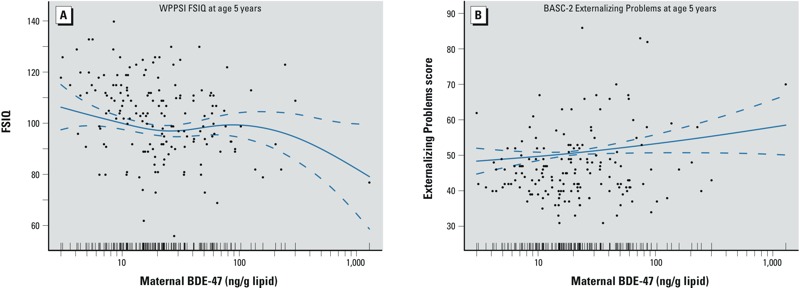
Scatter plots of maternal serum BDE‑47 concentrations and child cognitive and behavior rating scores at age 5 years with generalized additive model curve fitting: (A) WPPSI FSIQ; (B) BASC-2 Externalizing Problems. Data points represent paired data from each mother–child dyad. Solid lines indicate the natural cubic spline of the covariates adjusted association, and dotted lines represent 95% CIs. The density of BDE‑47 distribution is shown as vertical bars on the log10-transformed x‑axis. Covariates adjusted include maternal age at enrollment, race, education, marital status, maternal serum cotinine concentrations at enrollment, maternal IQ, child sex, maternal depression, household income, and HOME Inventory score.